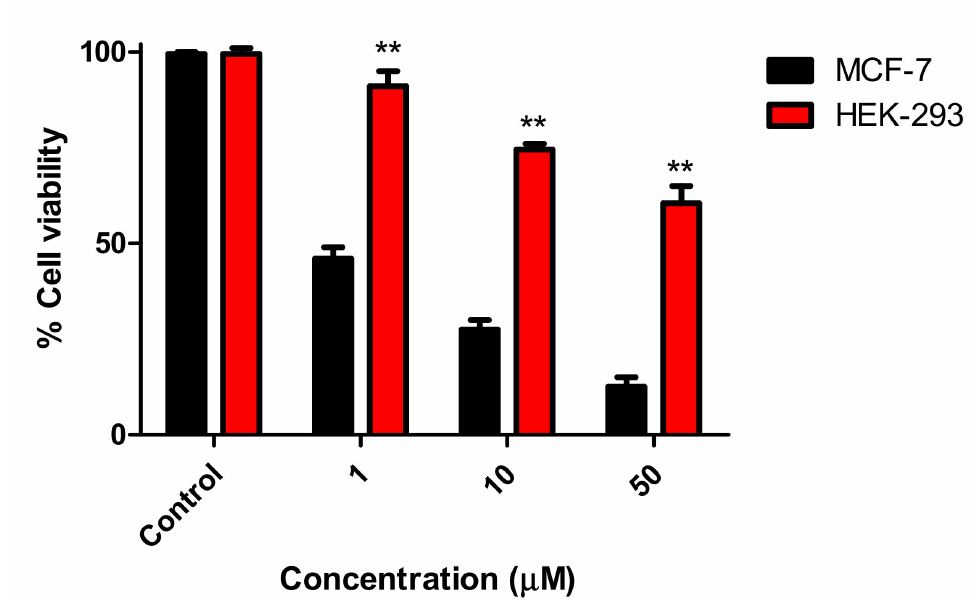
Figure 3. The effect of compound 3a on the proliferation of breast cancer MCF-7 cells and normal HEK-293 cells. The cells were treated at a concentration of 1, 10 or 50 µ M for 72 h. The statistical analysis was performed using a one-way ANOVA-Bonferroni post-hoc test (**, p <